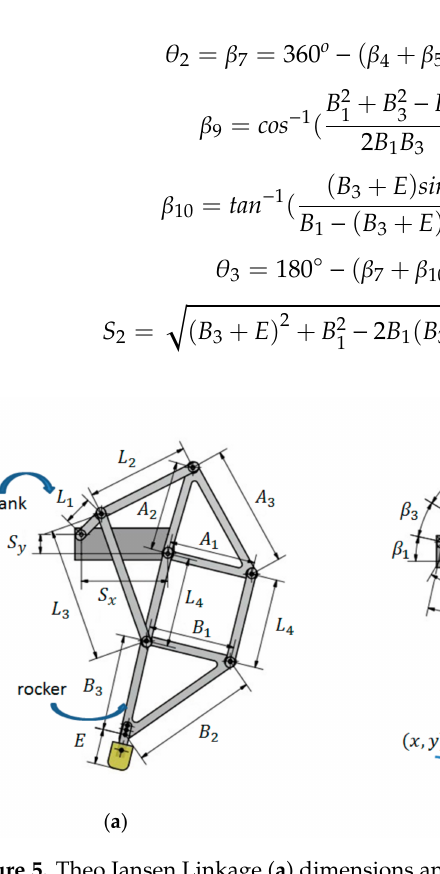
Figure 5. Theo Jansen Linkage ( a ) dimensions and ( b ) geometrical